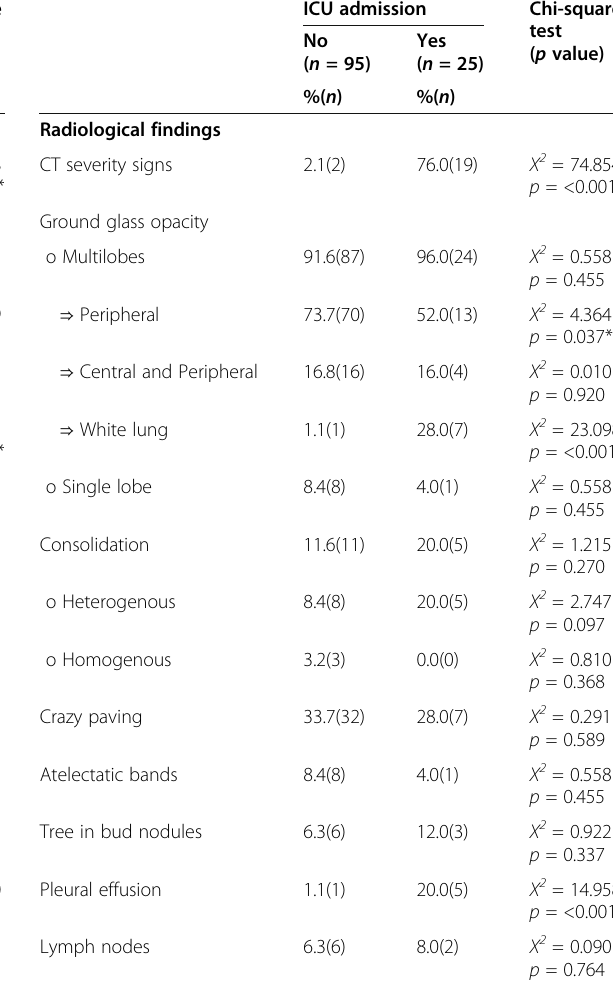
Table 5 Association between radiological findings with the need for ventilation